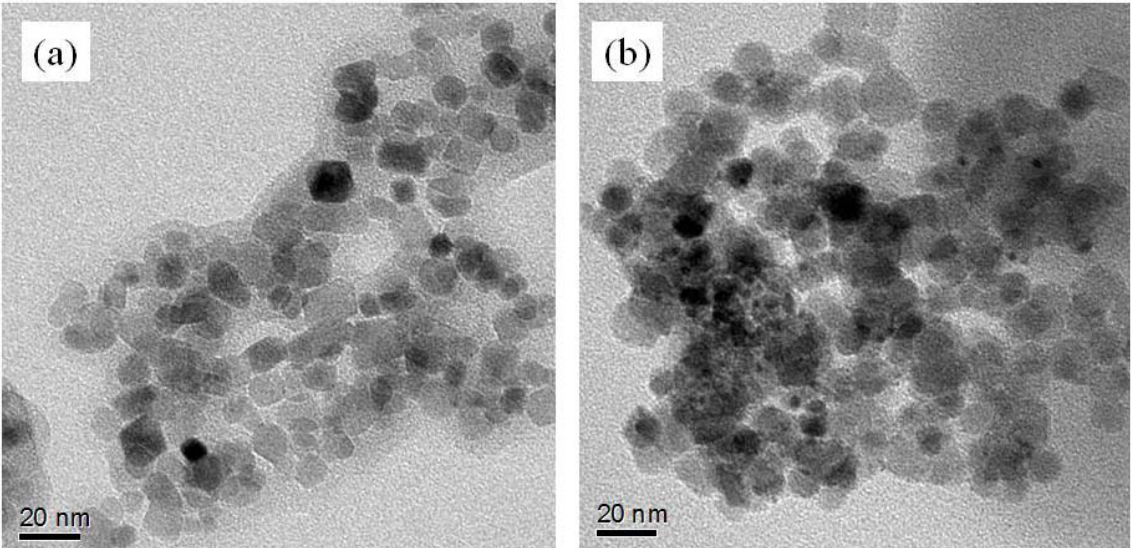
O :PVP support. (b) TEM image of the 3 4